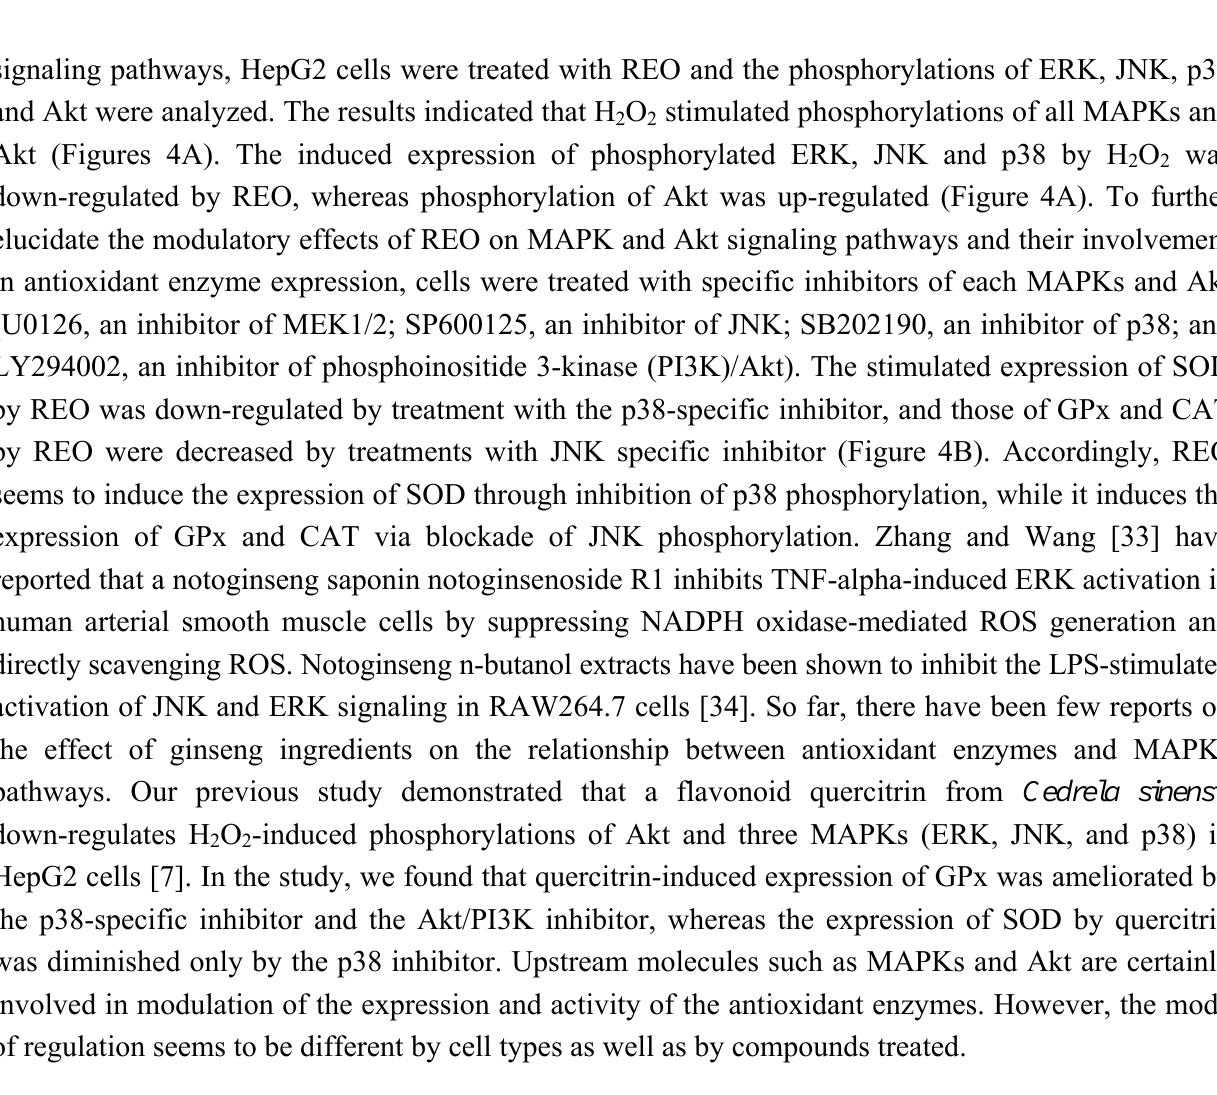
Figure 4. Effects of REO on mitogen-activated protein kinase (MAPK) and Akt phosphorylations. ( A ) HepG2 cells pretreated with vehicle or REO (100 μ g/mL)